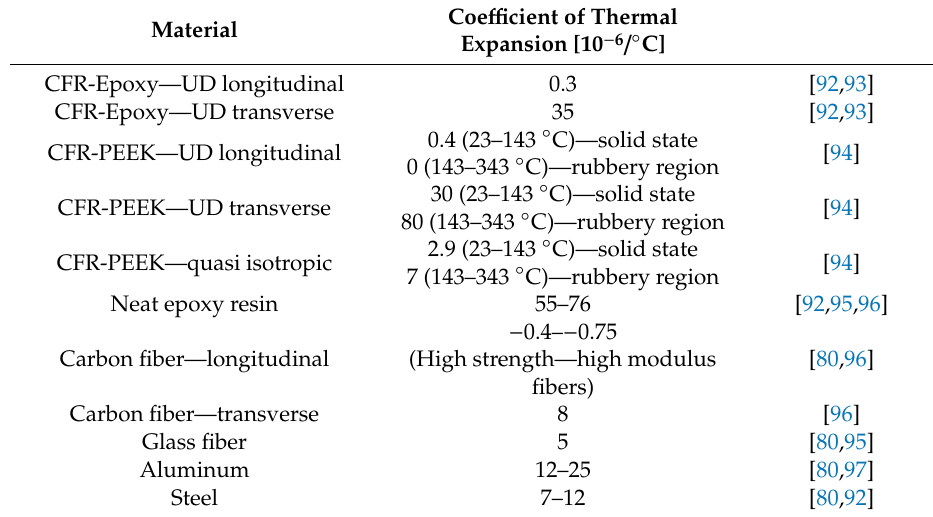
Table 2. Typical coe ffi cients of thermal expansion for composite materials and metals.